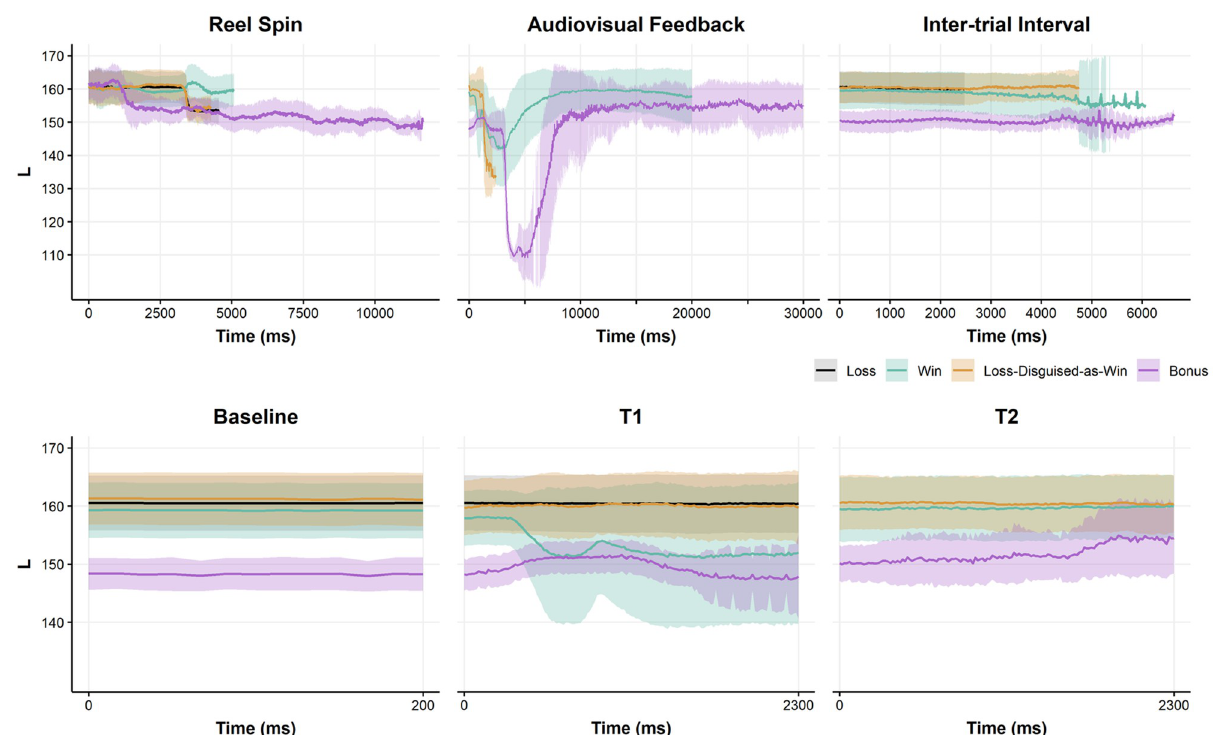
Fig 4. Buffalo spirit slot machine screen luminance by outcome phase. Average screen luminance (L) component from CIELAB color space time- locked to event onset. L range = 0–255, Audiovisual Feedback Time ranged from 0–140,430 ms; a narrower range limited at 30,000 ms is presented for easier inspection and comparisons to T1. Ribbons represent one standard deviation above and below the mean of 7284 loss (79.2%), 909 win (9.9%), 942 loss-disguised-as-win (10.2%), and 62 bonus (0.7%) outcomes at a given point in Time. Baseline and Reel Spin outcomes do not align due to discarded frames in the latter.